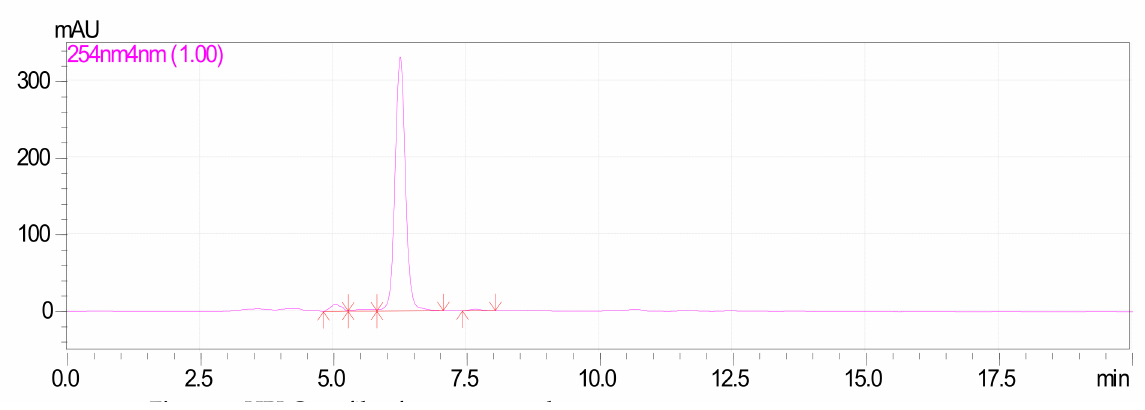
Figure 3. HPLC profile of oxyresveratrol.